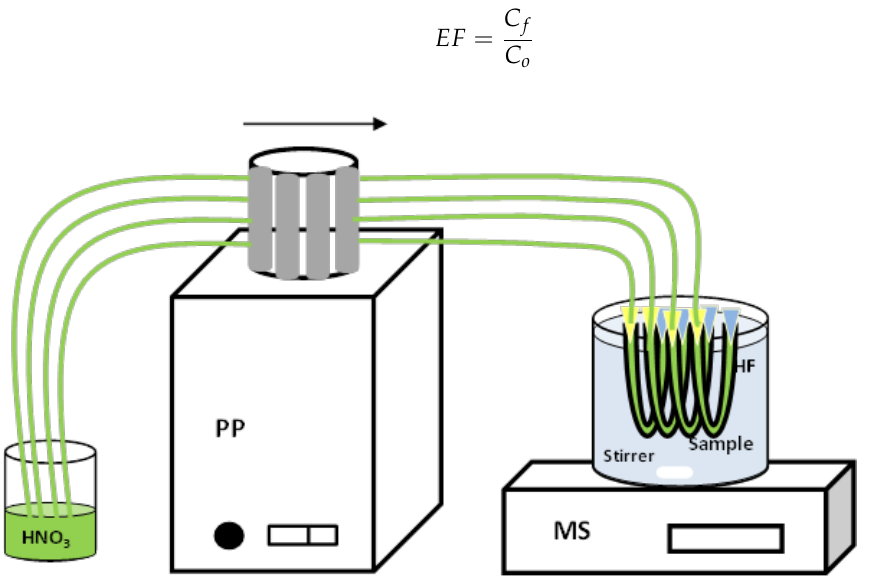
Figure 1. Set-up of the HF-LPME system. PP: Peristaltic pump. MS: Magnetic stirrer. HF: hollow fibre.